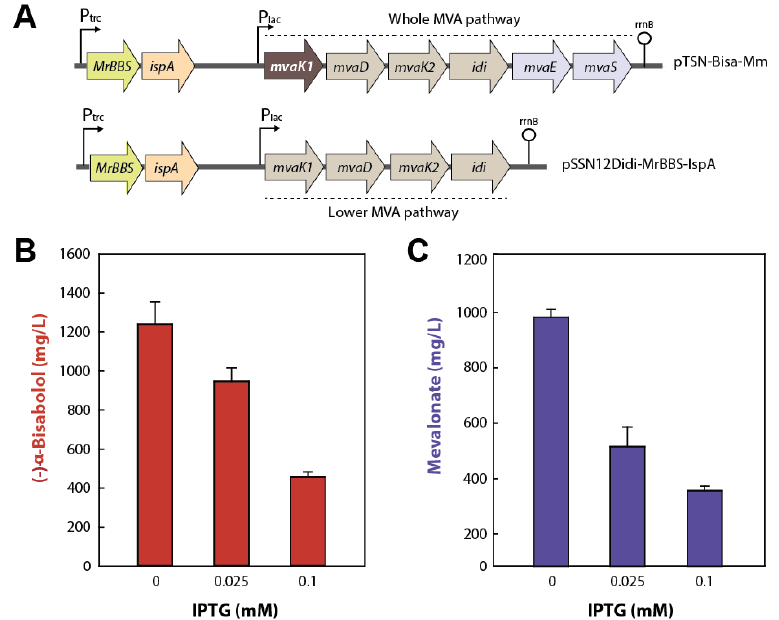
Figure 4. (−)-α-Bisabolol production in E. coli DH5α containing pTSN-Bisa-Mm and pSSN12Didi-MrBBS-IspA which has genes involved in the MVA lower pathway including Sp MvaK1, IspA and Mr BBS. ( A ) Plasmid constructs for expressing genes of entire (−)-α-bisabolol biosynthetic pathway or lower MVA pathway. The concentrations of (−)-α-bisabolol ( B ) and MVA ( C ) produced by the engineered E. coli DH5α harboring pTSN-Bisa-Mm and pSSN12Didi-MrBBS-IspA. Cells were cultivated in TB medium containing 10 g/L glycerol and 20% (v/v) of n -dodecane in the presence of different IPTG concentrations (0, 0.025 and 0.1 mM) at 30 °C for 72 h. The error bars represent the standard deviation of the concentrations of (−)-α-bisabolol and MVA from three biological replicates.